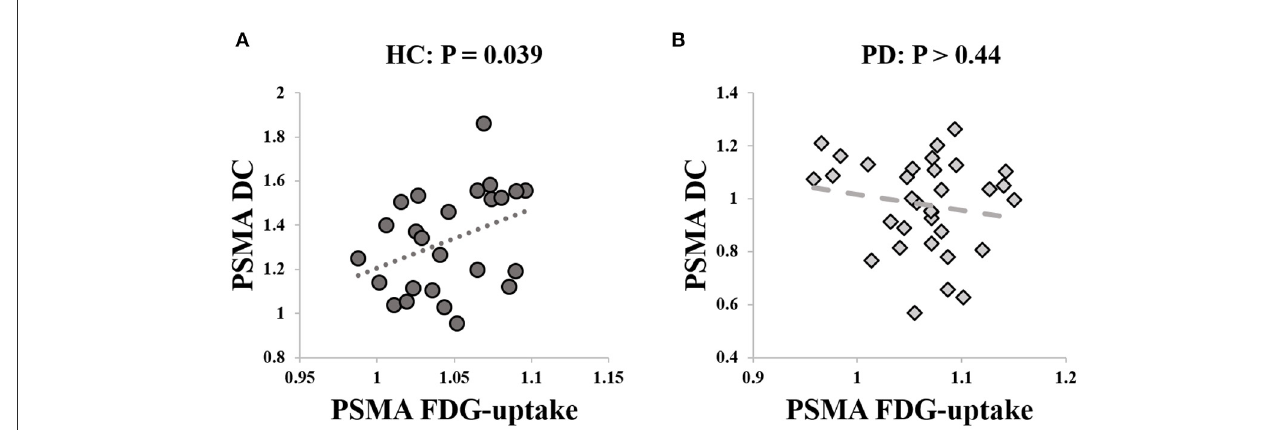
FIGURE3 Correlation between PSMA DC and FDG-uptake. (A) Significant correlation was identified between PSMA DC and FDG-uptake in the HCs (rho = 0.42, P = 0.039). (B) The correlation between PSMA DC and FDG-uptake was not significant in PD patients ( P > 0.44).